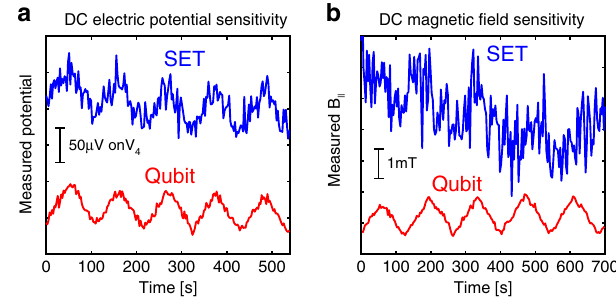
Fig. 6 Comparing SET and qubit performance in sensing DC electric potential and DC magnetic fi elds. a DC electric potential measurement: we slowly ramp the potential of a single gate ( V 4 ) up and down (sawtooth) with a period of ~100 s, and probe it using the device in SET modality (blue) or by detecting qubit state transitions using the time domain sequence described in Fig. 4a (red). The potential scale is shown by the vertical bar. b Similarly, but now for DC magnetic fi eld measurement. In both quantities, we observe a signi fi cant improvement in sensitivity when the device operates in qubit modality rather than SET times as compared to the results above. However, the sensitivity of these qubits to external magnetic fi elds is rather limited as compared to that of the atomic-like qubit demonstrated here. The two primary reasons are the exchange coupling to the feromagnetic leads, which results in weak coupling to an external fi eld, and the fact that the magnetic moment difference between the two qubit basis states is that of a single spin, ~30 times smaller